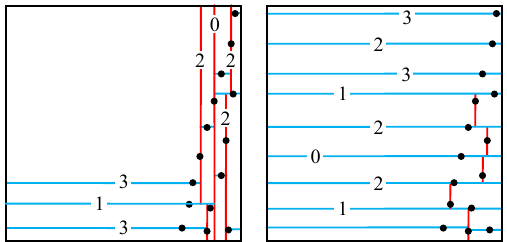
Figure 4: Splitting lines using the original k-d tree algorithm (left) and a median of maximum spread split